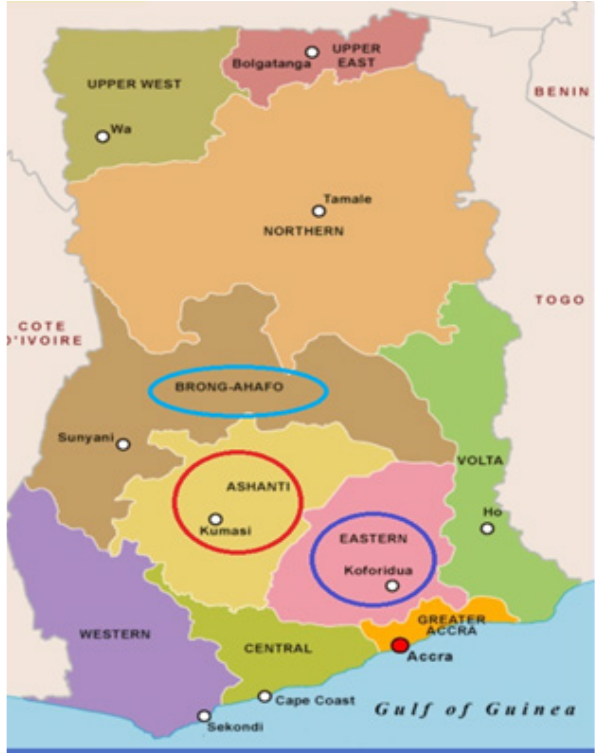
Figure 1: Map of Ghana showing the study area. Source: https:// mfa.gov.gh/index.php/about-ghana/regions/ The three regions fall within the semi-deciduous rainforest and the forest savannah transition agro ecological